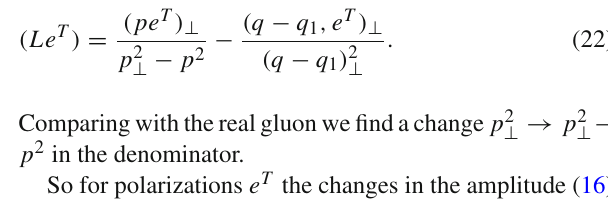
tive vertices in Lipatov’s effective action. Discs with crosses indicate the so-called induced vertices. The dot in diagram 2 corresponds to the QCD 4-gluon